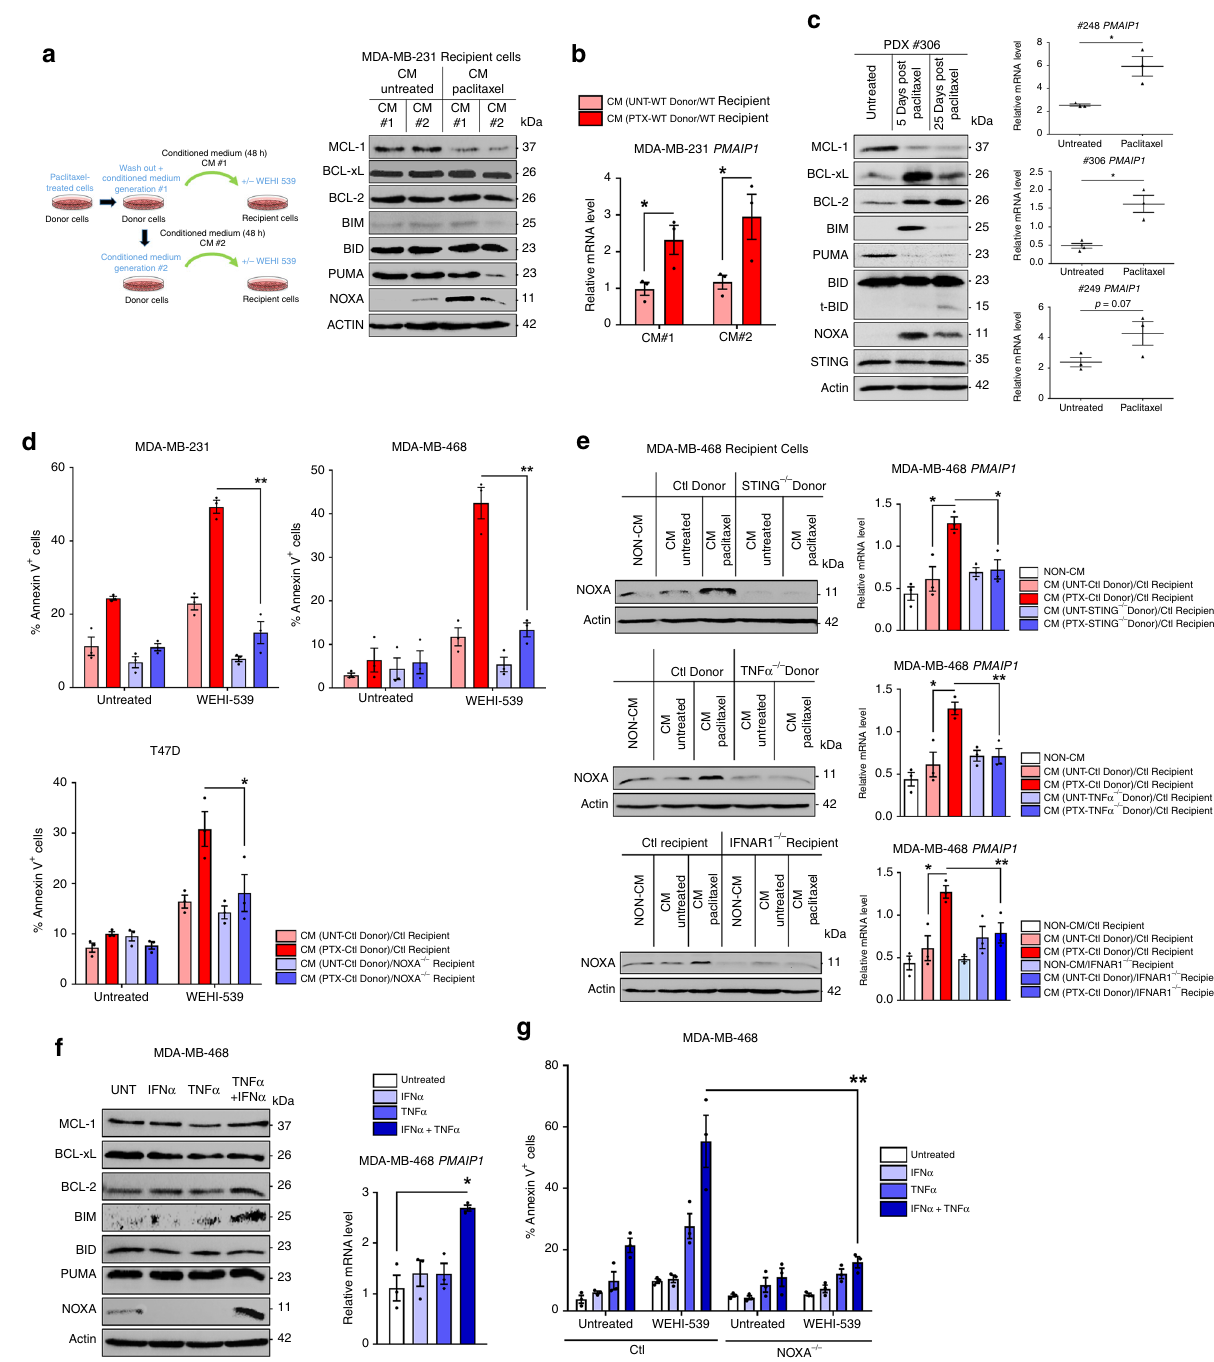
Fig. 5 NOXA is induced by STING-dependent extrinsic paclitaxel-induced apoptotic priming signals. a, b Immunoblot ( a ) and PMAIP1 qPCR ( b ) analysis in MDA-MB-231 recipient cells 48 h incubated with #1 or #2 consecutively produced CM as described in the protocol depicted in the fi gure. c Immunoblot and PMAIP1 qPCR analysis in PDX treated or not by paclitaxel after indicated times. d After a 24 h paclitaxel-treatment or not, (donor) breast cancer cells were washed out to produce 48 h-CM that were applied to control or NOXA − / − untreated (recipient) corresponding cancer cells for 48 h in presence or not of the BH3 mimetic WEHI-539. Apoptotic index in recipient breast cancer cells was assessed using Annexin-V staining. e NOXA immunoblot (left panel) and PMAIP1 qPCR (right panel) analysis in MDA-MB-468 recipient cells incubated for 48 h with 48 h-CM from control, STING − / − or TNF α − / − donor cells treated or not with paclitaxel (upper panel) and in control or IFNAR1 − / − MDA-MB-468 recipient cells with 48 h-CM from control donor cells treated or not with paclitaxel (lower panel). f Immunoblot and PMAIP1 qPCR analysis in MDA-MB-468 cells treated for 48 h or not with recombinant TNF α and/or IFN α . g Apoptotic effect of recombinant IFN α and/or TNF α on control or NOXA − / − MDA-MB-468 cells treated or not with WEHI-539 during 48 h. Data were collected from at least n = 3 independent experiments. Error bars indicate mean + / − SEM; Two-sided paired t -test. The symbols correspond to a p -value inferior to *0.05 and